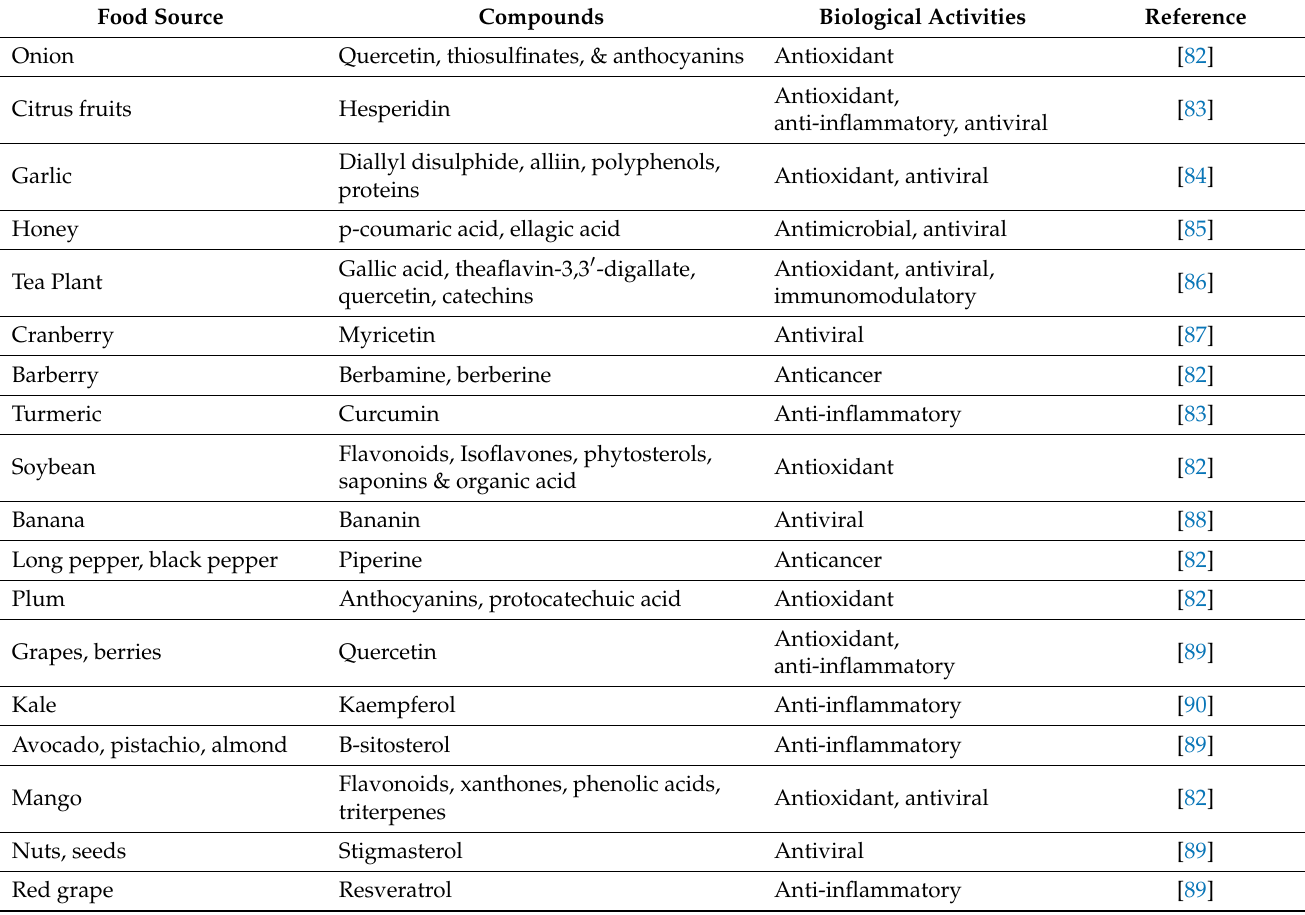
Table 2. Biological activities of foods bioactive